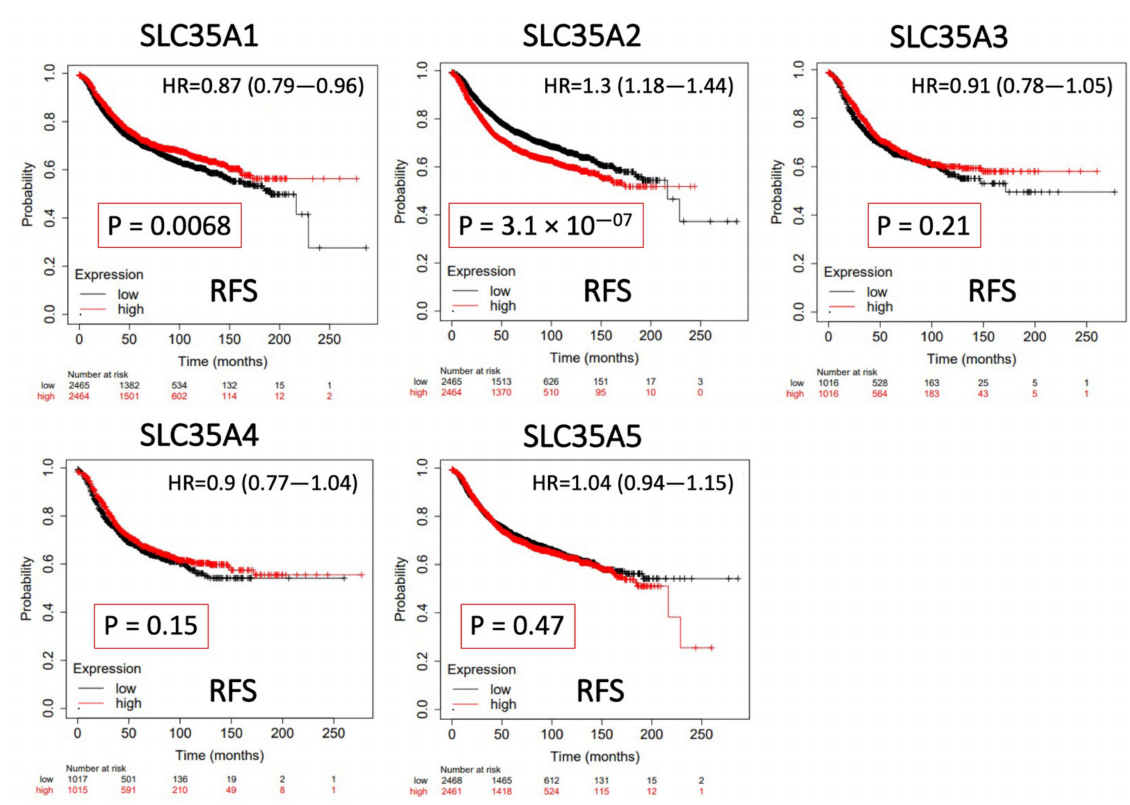
Figure 6. Significant correlations between mRNA levels of solute carrier 35A (SLC35A) family members and the recurrence- free survival (RFS) curve of patients diagnosed with breast cancer (BCRA). The two survival curves respectively illustrate survival outcomes (including survival percentages and survival times) of BRCA patients with high (red) or low expression (black) levels of SLC35A family members. Increased mRNA levels of SCL35A2 resulted in a poor prognosis, while increasing levels of the remaining members were associated with favorable outcomes. SLC35A3, SLC35A4, and SLC35A5 were not statistically significant ( p <